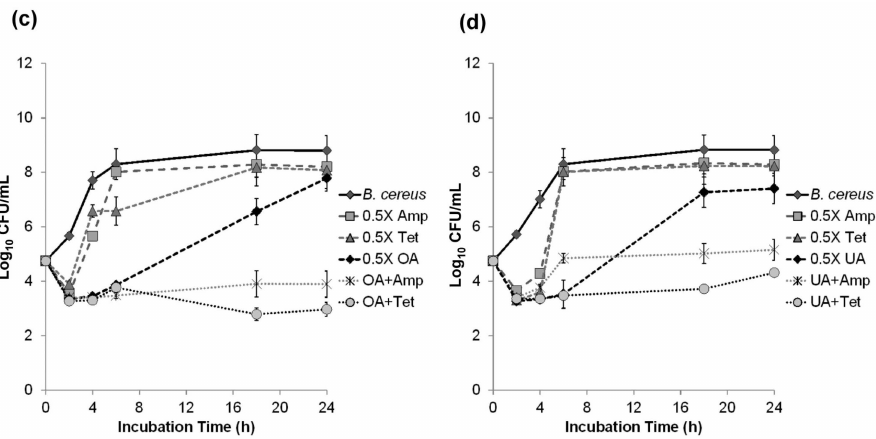
Figure 2. Time-kill curves of MSSA ( a ); MRSA ( b ) and B. cereus ( c , d ) with 1/2 MICs of antibiotics and triterpenoids. Ampicillin (Amp); Tetracycline (Tet); Ursolic acid (UA); Oleanolic acid